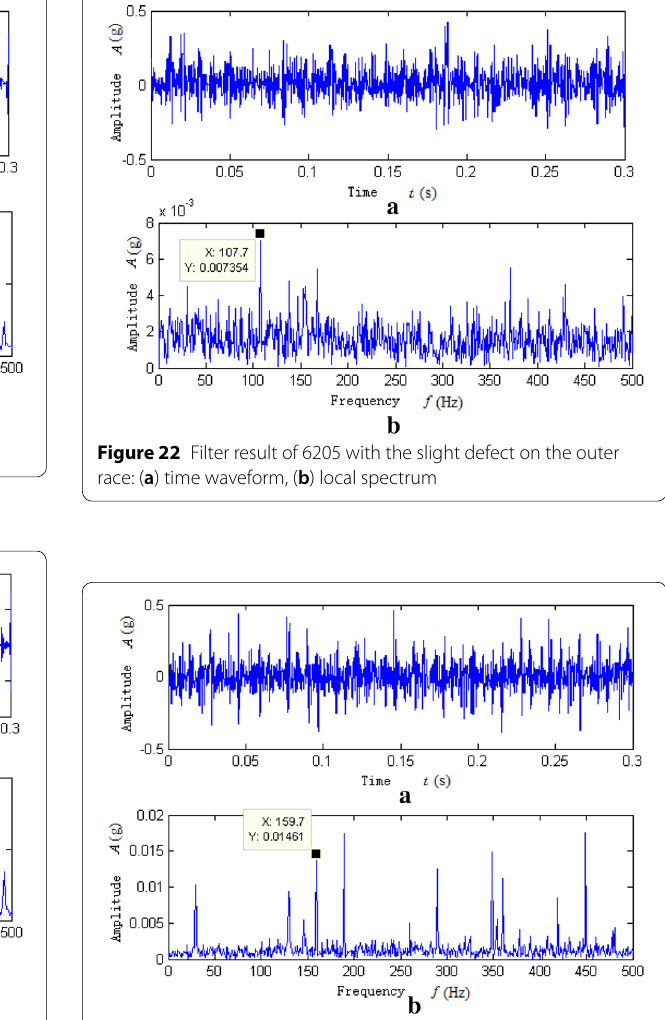
Figure 23 Filter result of 6205 with the slight defect on the inner race: ( a ) time waveform, ( b ) local